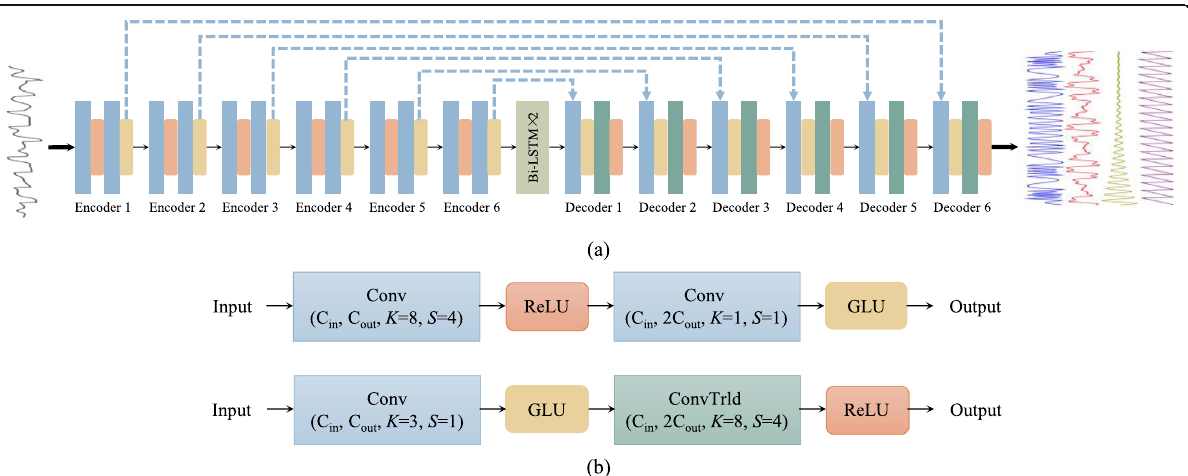
Fig. 5 The structure of U-Net in Demucs and the structure of Encoder and decoder in U-Net. A The structure of U-Net. B Detailed view of the layers Encoder i (upper) and Decoder i (below)